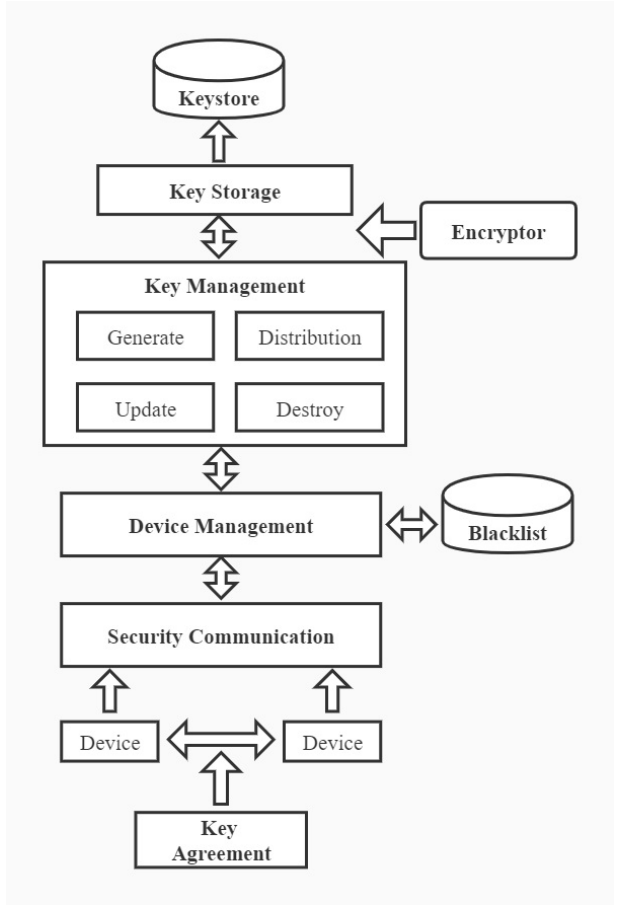
Fig. 3 Key management system logical